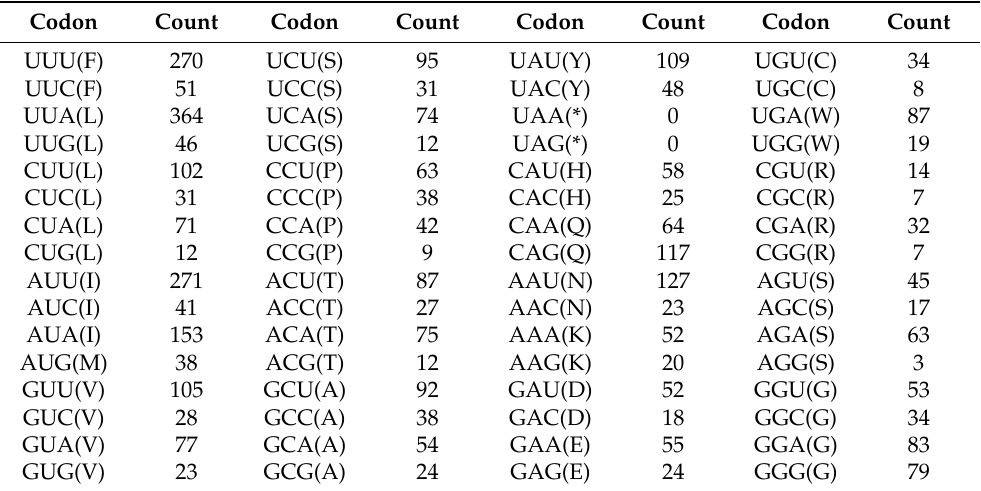
Figure 2. The relative synonymous codon usage (RSCU) in the mitogenome of M. flexura . PCGs represent protein-coding genes. Table 4. Codon number in the M. flexura mitochondrial